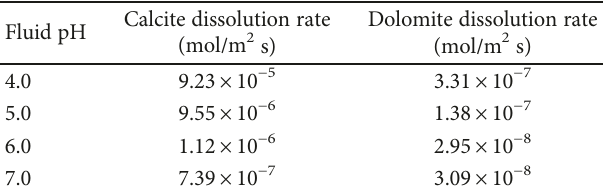
Table 6: Comparison of dissolution rate of calcite and dolomite under various fl uid